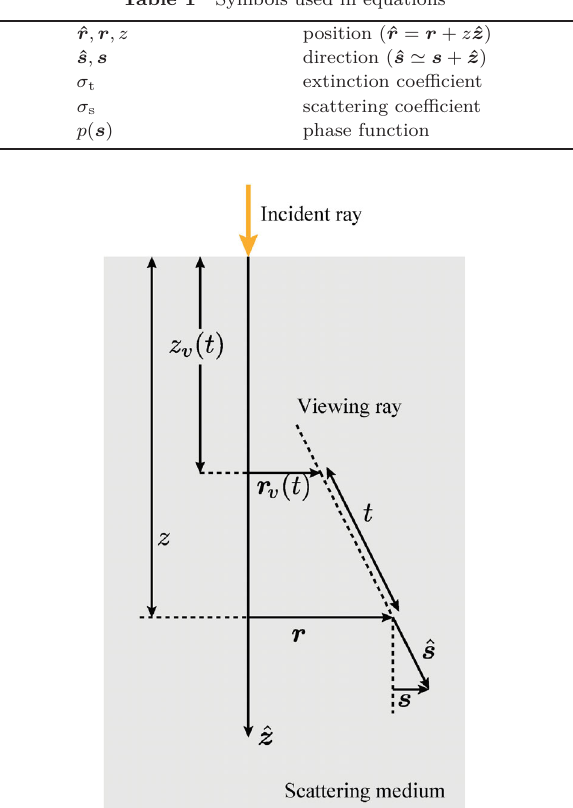
Fig. 1 Coordinate